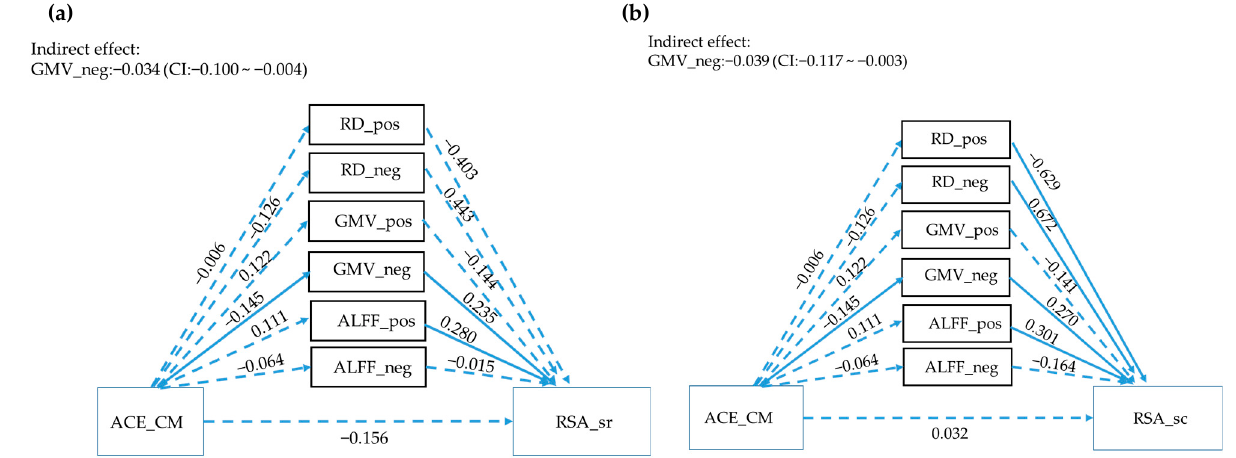
Figure 1. Parallel mediation analyses of ACEs, multimodality imaging, and RSA. Solid lines represent significant paths ( p < 0.05), while the dashed line represents non-significant paths. ( p > 0.05). Path values represent standardized β weights and p values. CI represents the 1000 samples